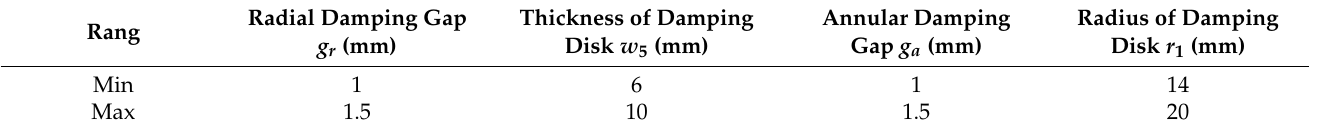
Table 2. Sampling range of each design variable.